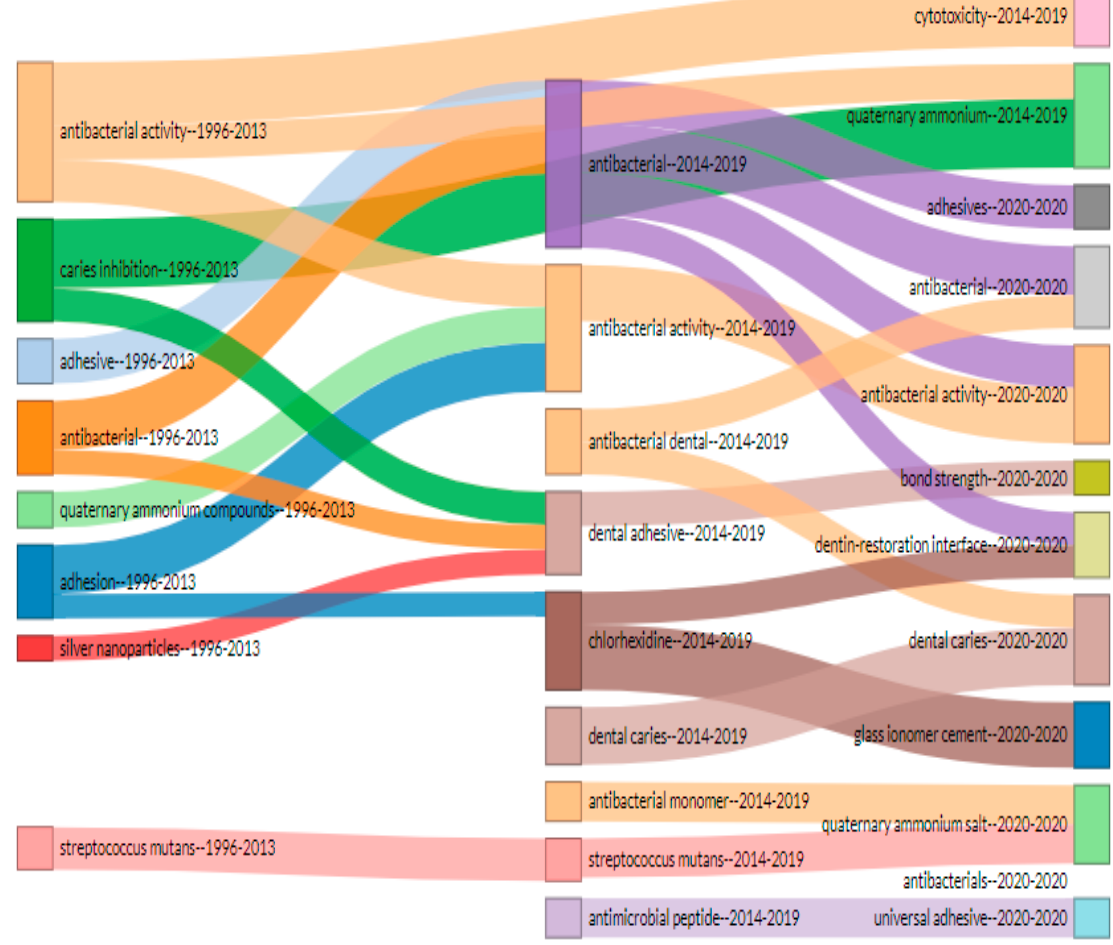
Figure 5. Thematic evolution map of keywords from 1996 to 2020 with respect to antibacterial dental adhesives. This map highlights the usage and emergence of various keywords related to antibacterial dental adhesive literature. It is evident that antibacterial activities, adhesive, antibacterial, quaternary